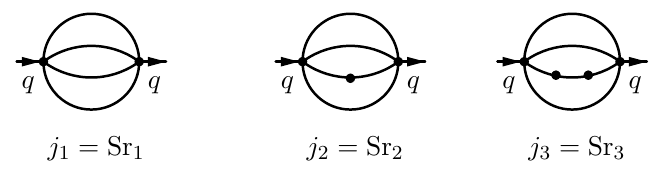
Figure 4 . The three-loop sunrise